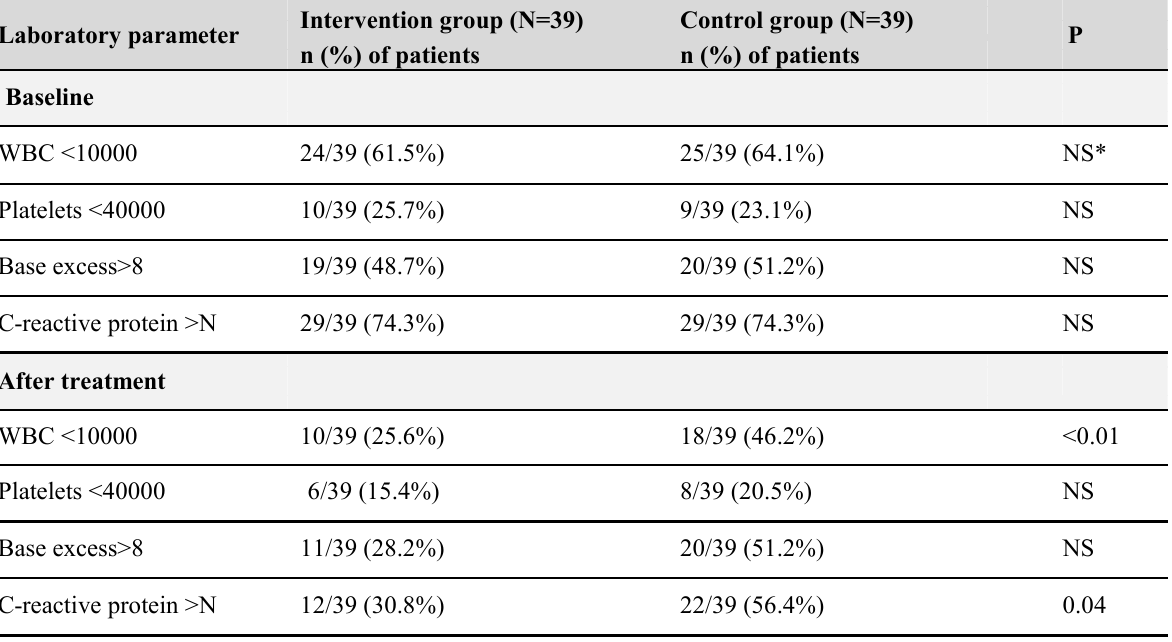
Table 2. Patients with abnormal laboratory values before and after treatment Intervention group (N=39) Control group (N=39) Laboratory parameter P n (%) of patients n (%) of